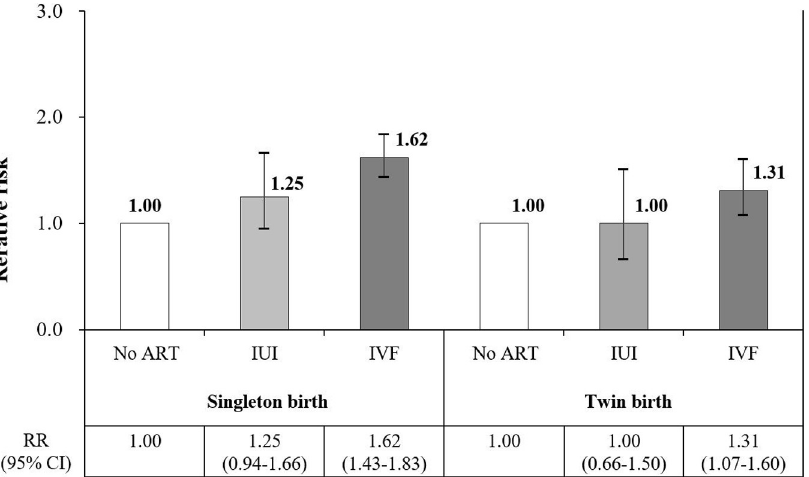
Fig 1. Analysis of the association between ART and SMM, stratified by twin birth status. Data are shown after adjustment for maternal age, income level, type of insurance, residential area, work status, mode of delivery, preterm birth status, prenatal care, parity, comorbidities during pregnancy, and hospital type. Abbreviations: ART, assisted reproductive technology; SMM, severe maternal morbidity; IUI, intrauterine insemination; IVF, in vitro fertilization; RR, risk ratio; CI, confidence